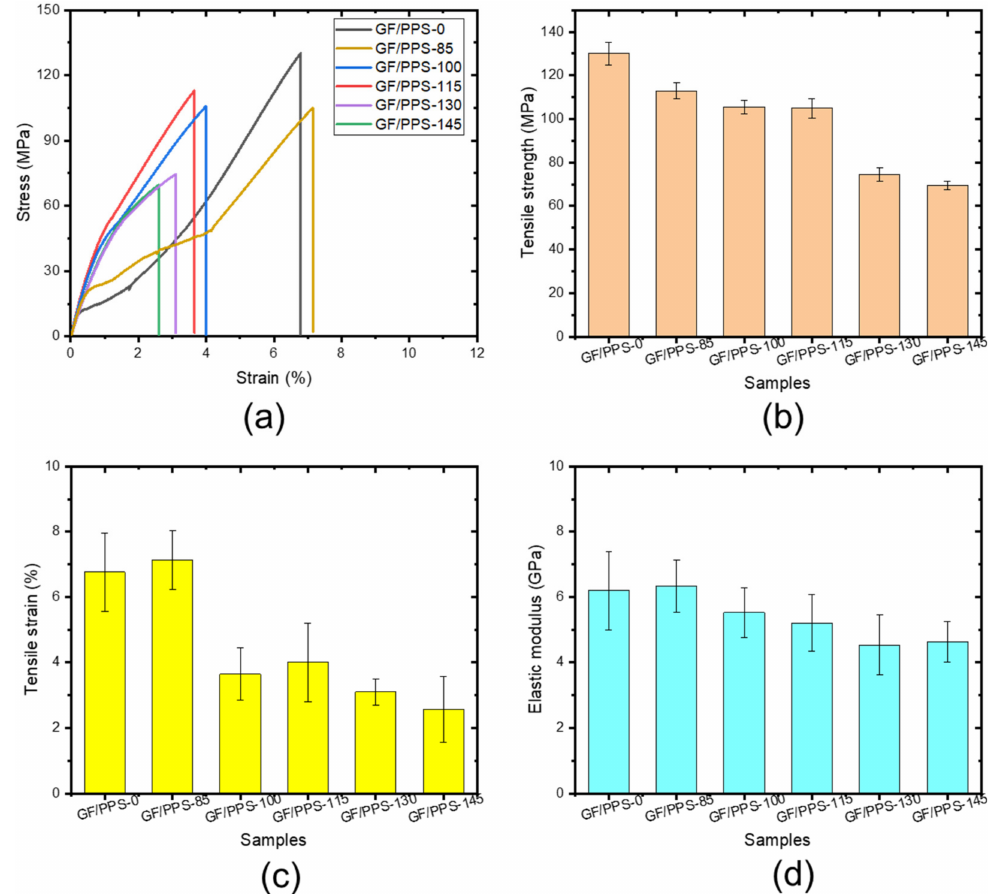
Figure 2. Tensile stress–strain curves ( a ), tensile strength ( b ), tensile strain ( c ), elastic modulus ( d ) of the thermally aged